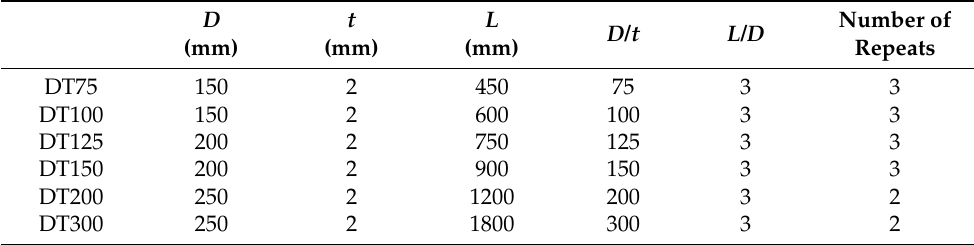
Table 2. Geometric parameters of specimens were tested by Lanhui Guo et al. (Reprinted from Ref. [13]).